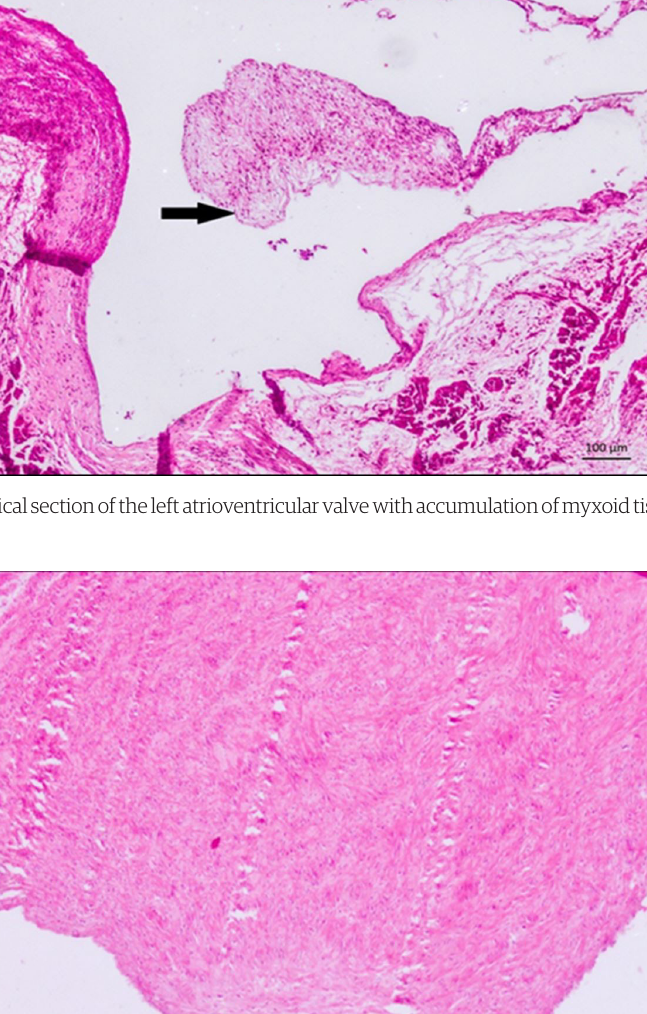
in the pulmonary veins, occurring due to left atrioventricular reflux and decreased cardiac output. Untreated pulmonary congestion can lead to overloading of the right side of the heart, which is sensitive to increased pressure in the pulmonary vessels. This is due to the relative thinness of the right ventricular wall and the anatomy of the atrioventricular valve, which changes along with the myocardium, increasing in size and promoting atrioventricular reflux (Oglesbee & Lehmkuhl, 2001).